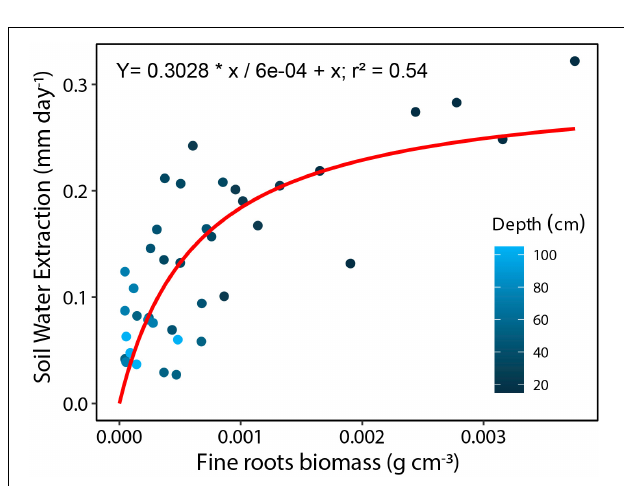
FIGURE 7 | Soil water extraction by layer for the top 1 m of soil based on measured volumetric water contents (10, 20, 30, 40, 50, 70, 100 cm) as a function of fine root biomass within each layer for a tropical monsoon forest in central Amazonia. Darker circles are shallower depths.